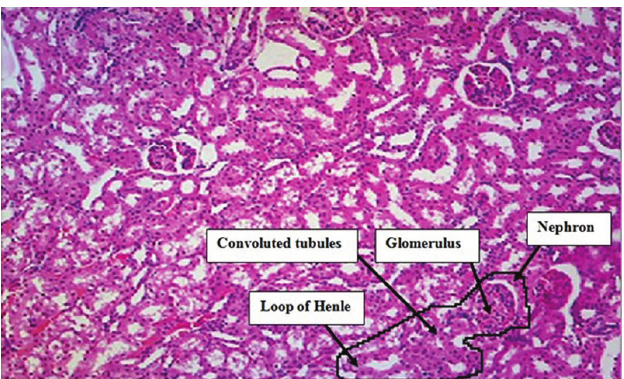
FIGURE 11 - Effect of risperidone on the kidneys of rats (2.5 mg/kg/d) (H & E, 100x, 5 µ): Representative image of kidney of rat treated with risperidone orally for three weeks showing intact cortical region of the kidney without any drug- induced architectural insult.